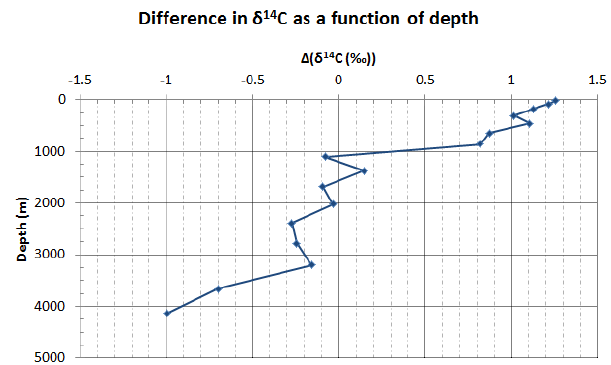
Fig. 6. Variations in δ 14 C anomaly as a function of depth in the Weddell Sea (region of negative temperature anomaly in Fig. 4), averaged over the 500 th year of the climate model simulation.